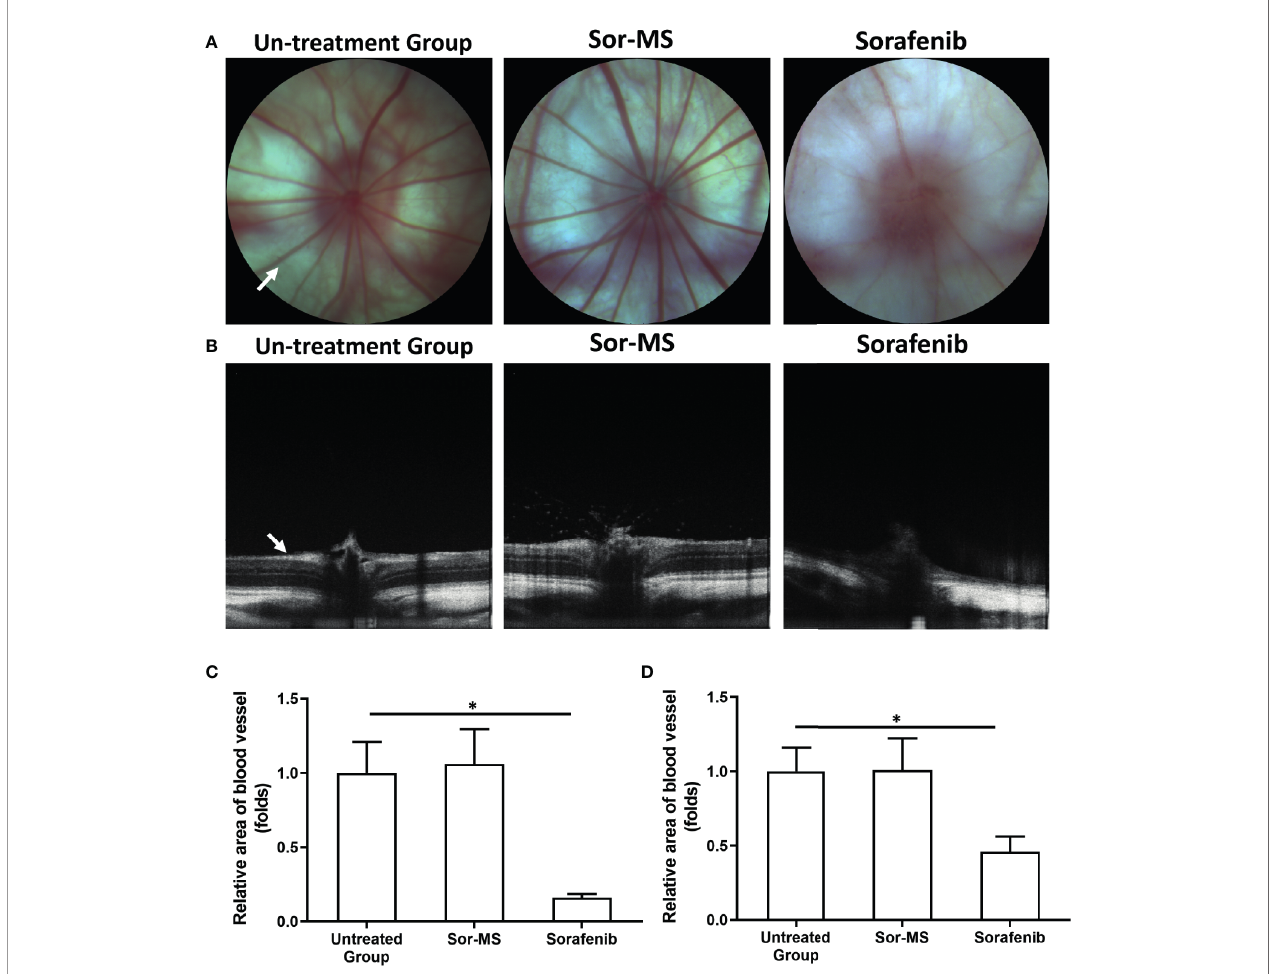
FIGURE 4 | Fundus intravital imaging of immunode fi ciency rats with intrahepatic lesions that received sorafenib formulations. MHCC97-H cells were cultured, and the intrahepatic lesions of hepatocellular carcinoma (HCC) were established in the live organs of immunode fi cient rats. Rats received one intratumor injection (50 m l amount) of sorafenib microcrystal formulation with the largest particle-size (Sor-MS) (30mg/ml) or sorafenib via oral administration (2mg/kg concentration, repeatedly over a long period of time). Results are shown as images of the fundus microcirculation capillary network (A) and fundus retinal intravital images (B) . Results are shown as images of the rat fundus retinal capillary network (A) , images of the rat fundus retinal thickness (B) , and a quantitative analysis of the images of the rat fundus retinal capillary network (C) or rat fundus retinal thickness (D) . *P < 0.05. The write arrow indicated the capillaries and retina.